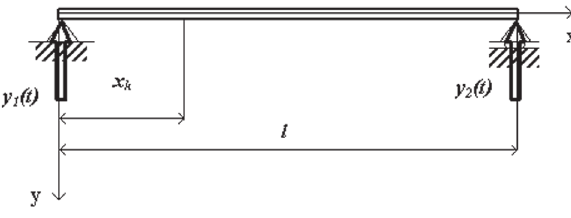
Fig. 1. Schema of the analyzed